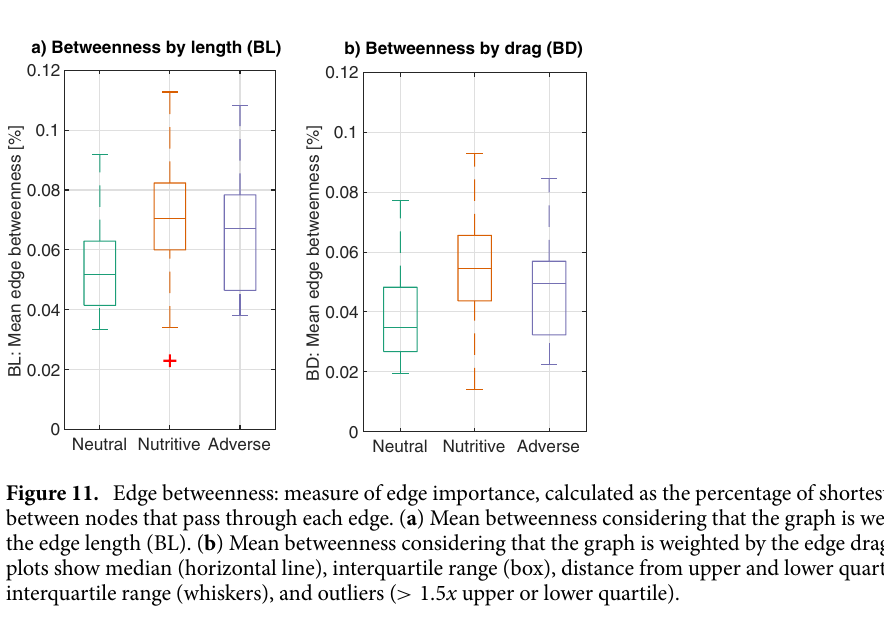
Figure 10. Transport efficiency. ( a ) Length efficiency distribution: ratio between the distance along the network and the Euclidean distance between every pair of nodes in the network. ( b ) Drag efficiency distribution: ratio between the drag along the network and along a straight path with a 0.5 mm width (arbitrary, constant value). The coefficient of variation (COV) corresponds to the standard deviation divided by the mean of the values. Box plots show median (horizontal line), interquartile range (box), distance from upper and lower quartiles times 1.5 interquartile range (whiskers), and outliers ( > 1.5 x upper or lower quartile).